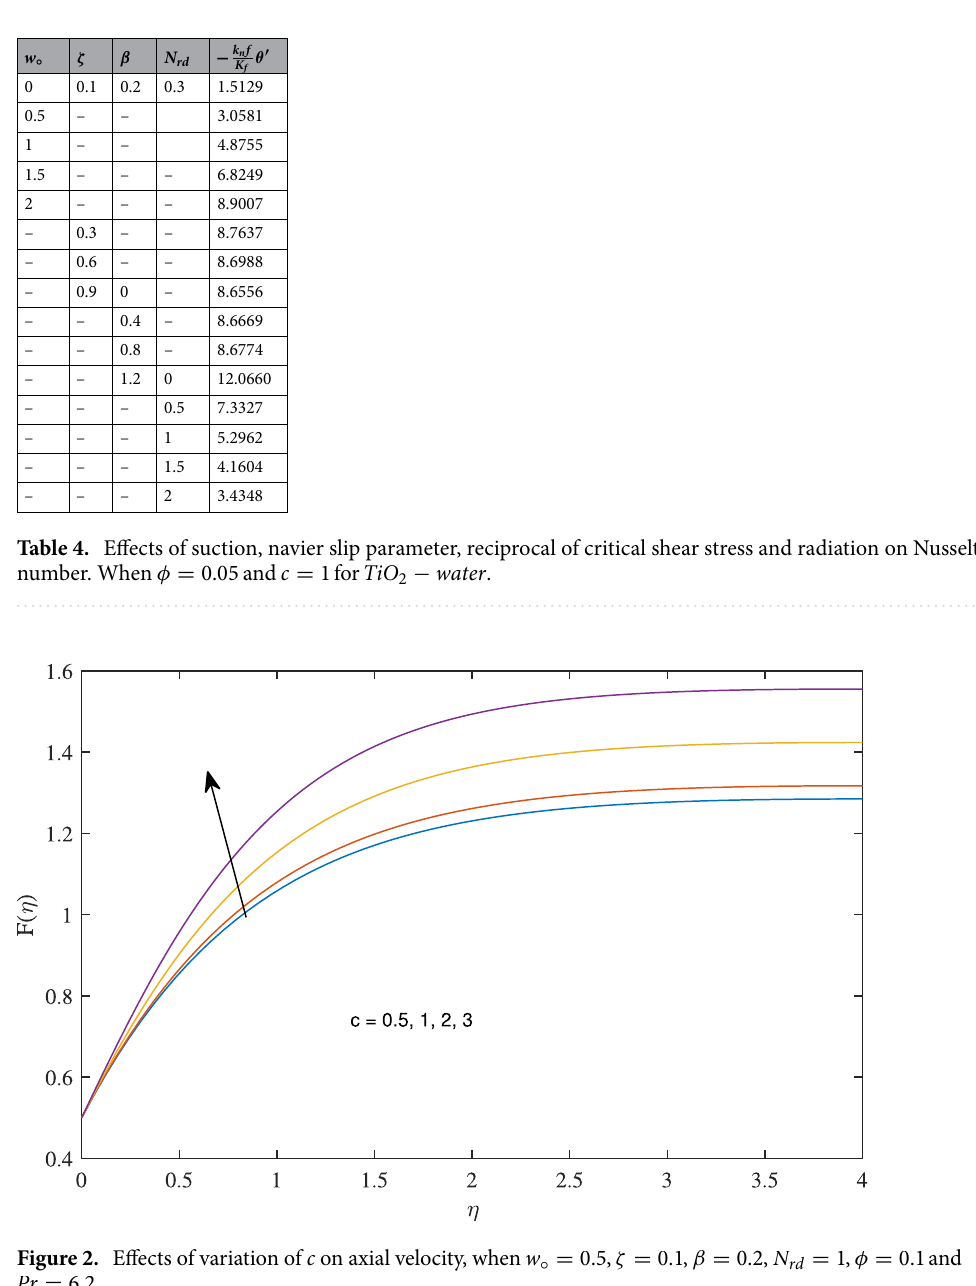
Figure 2. Effects of variation of c on axial velocity, when w 6.2 Pr =